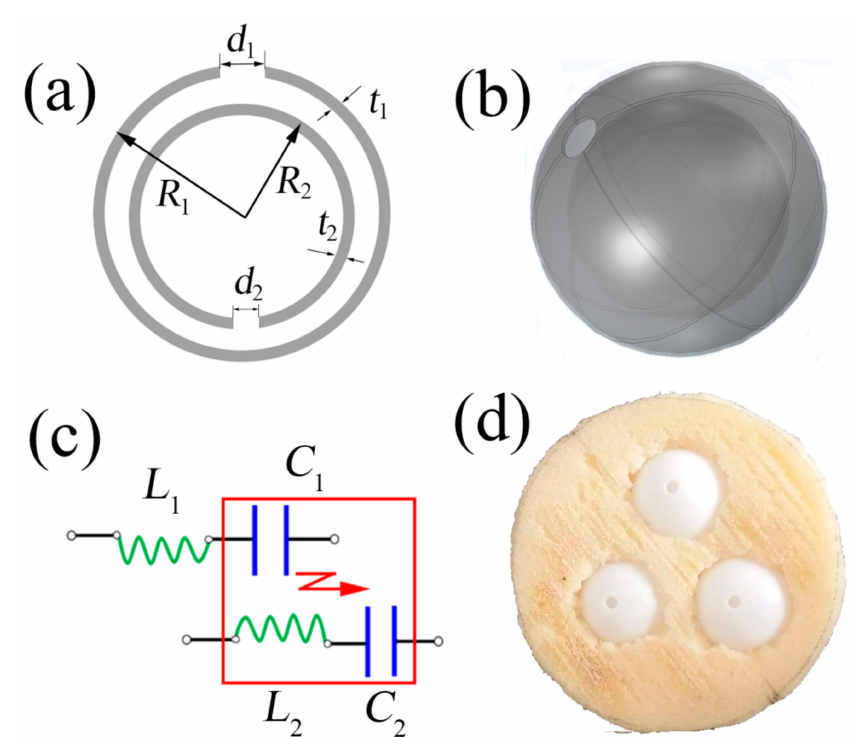
Figure 1. ( a ) 2D and ( b ) 3D schematic of the nested split hollow sphere (NSHS) structure, ( c ) e ff